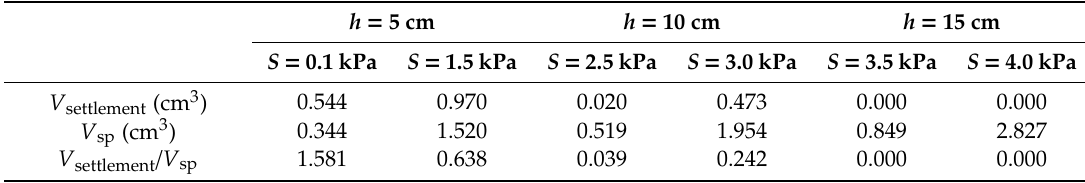
Table 3. The volume of soil plug and soil settlement in tests.